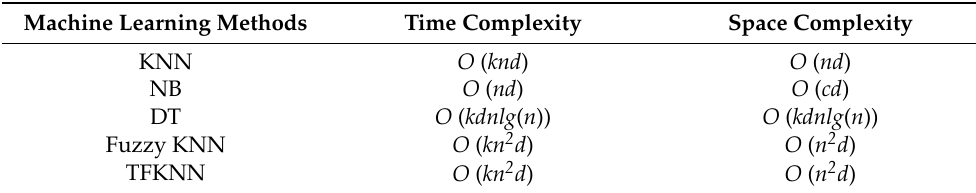
Table 5. Time complexity versus space complexity of the TFKNN compared with KNN, NB, DT, and fuzzy